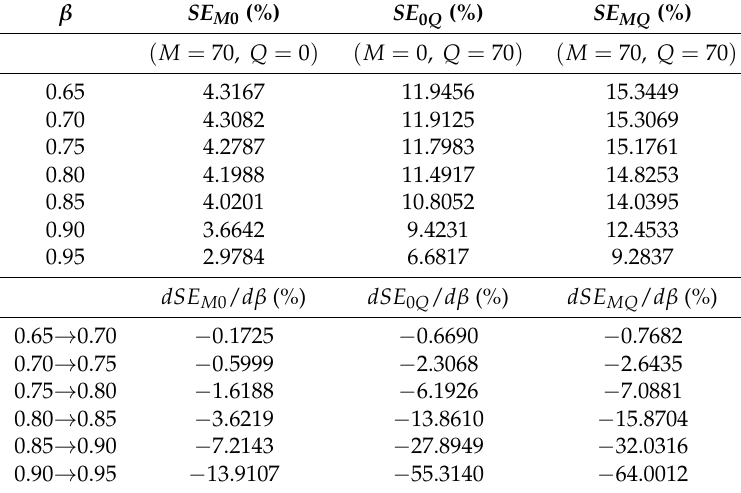
Table 9. Responsiveness of the bank’s scope equities to barrier at various levels of WMPs and/or ELs 1